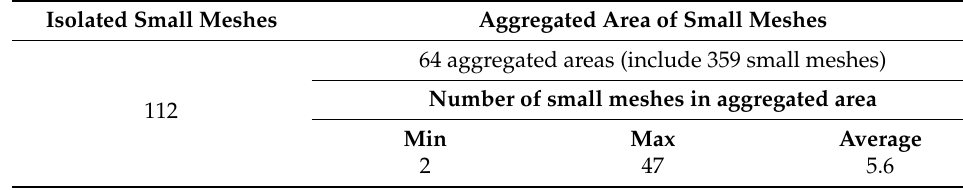
Table 1. The detailed classification of small